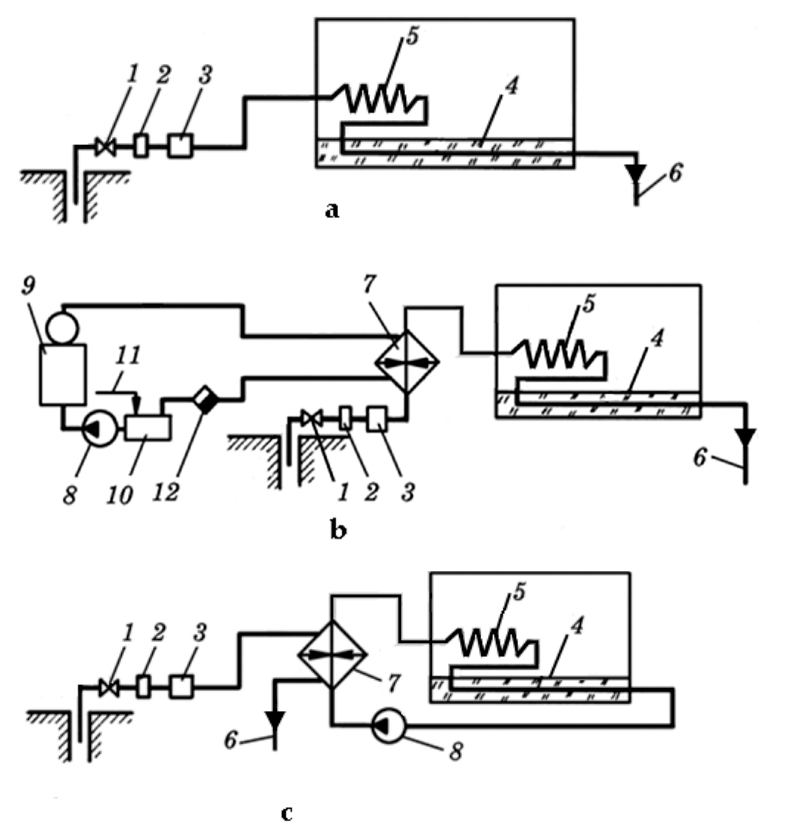
Figure 1. Heat supply schemes for greenhouses using geothermal waters: ( a ) directly; ( b ) with peak